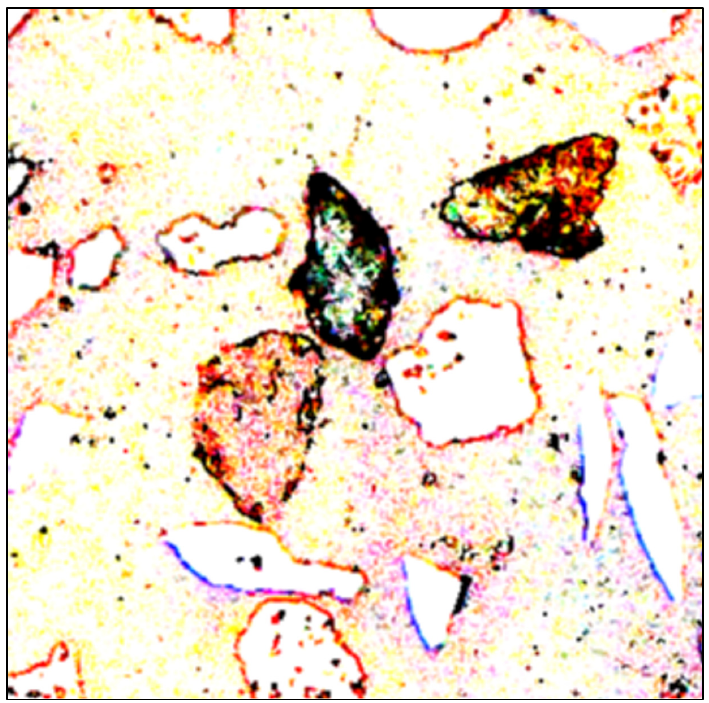
Figure 6. “Enhanced” view of the image from Figure 2 with a suitable selected reflectivity range (low threshold = 9000, high threshold = 10,000).